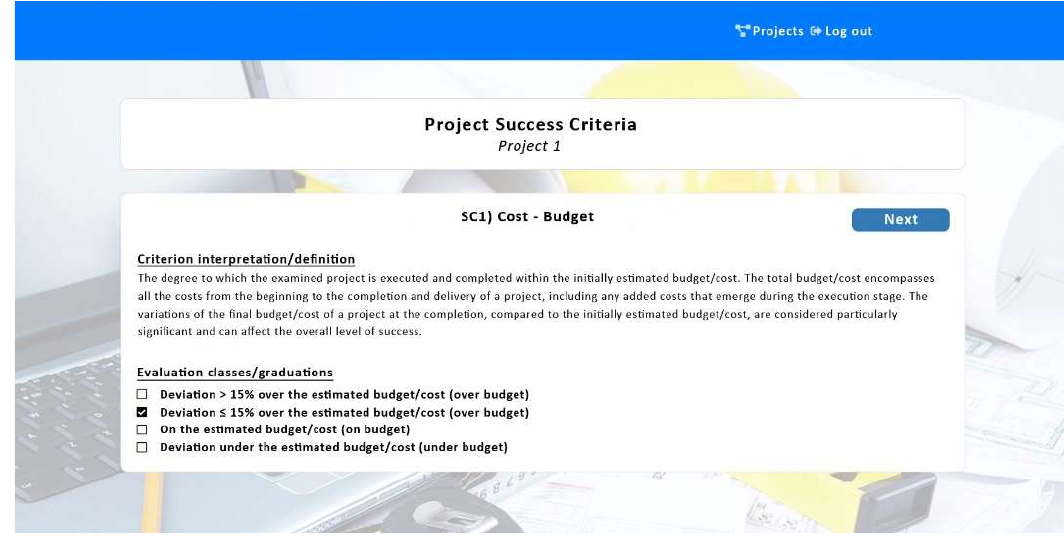
Figure 2. Evaluation of performance for the Cost/Budget success criterion.